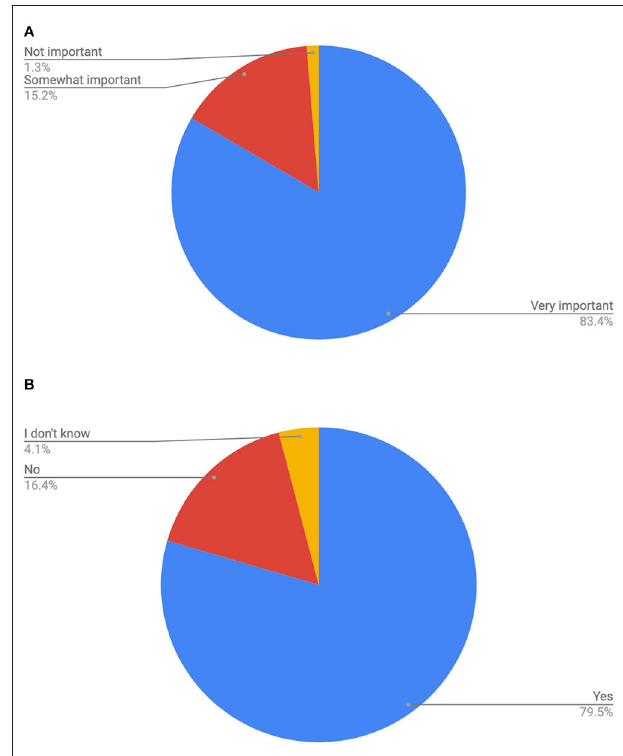
FIGURE 1 | (A) Count of how important is it that you are free to move as you like in labor? (Get in a tub or shower, go outside, change position…). (B) Count of were you restricted to bed at any time in